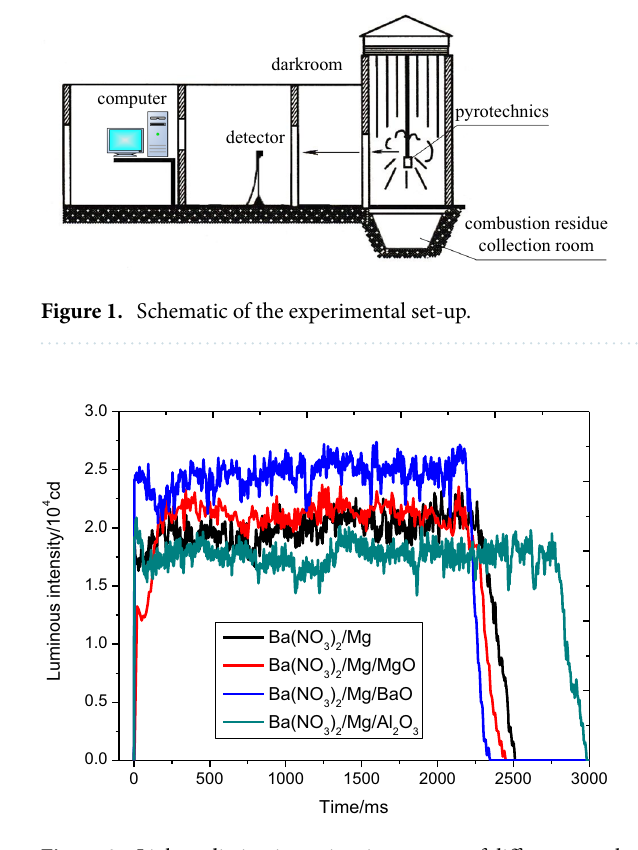
Figure 2. Light radiation intensity-time curves of different metal oxides.